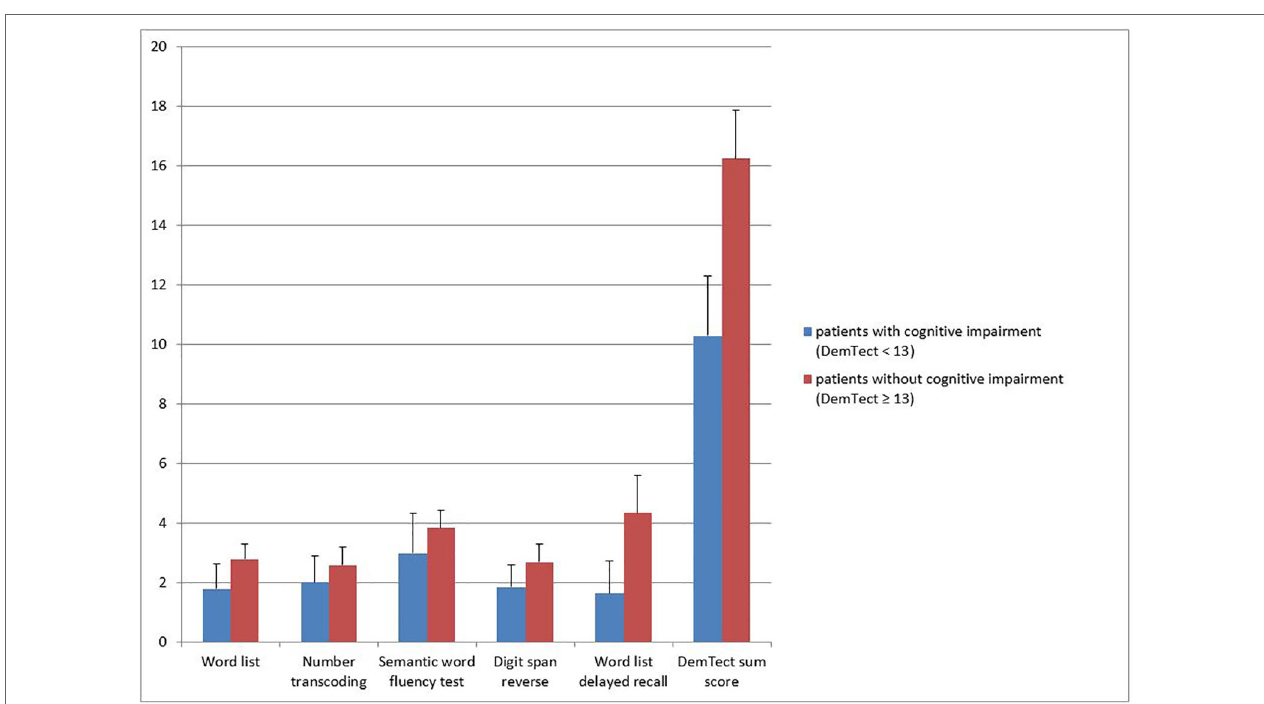
FIgURe 2 | Mean subtest scores and mean sum score for patients with and without cognitive